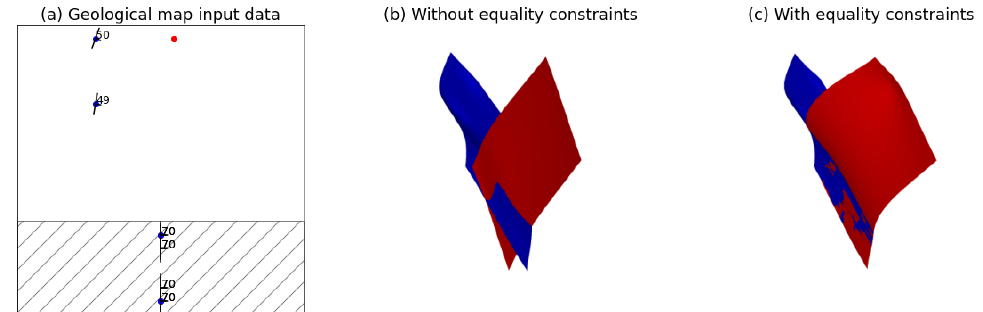
Figure 6. Comparison of fault surfaces modelled using equality constraints and without equality constraints. (a) Input datasets showing observations for both faults. The blue dots represent the location of the main fault and the red dot represents the location of the splay fault. The rectangle represents the area where the faults share the same geometry. (b) Fault surfaces modelled without equality constraints. (b) Fault surfaces modelled with equality